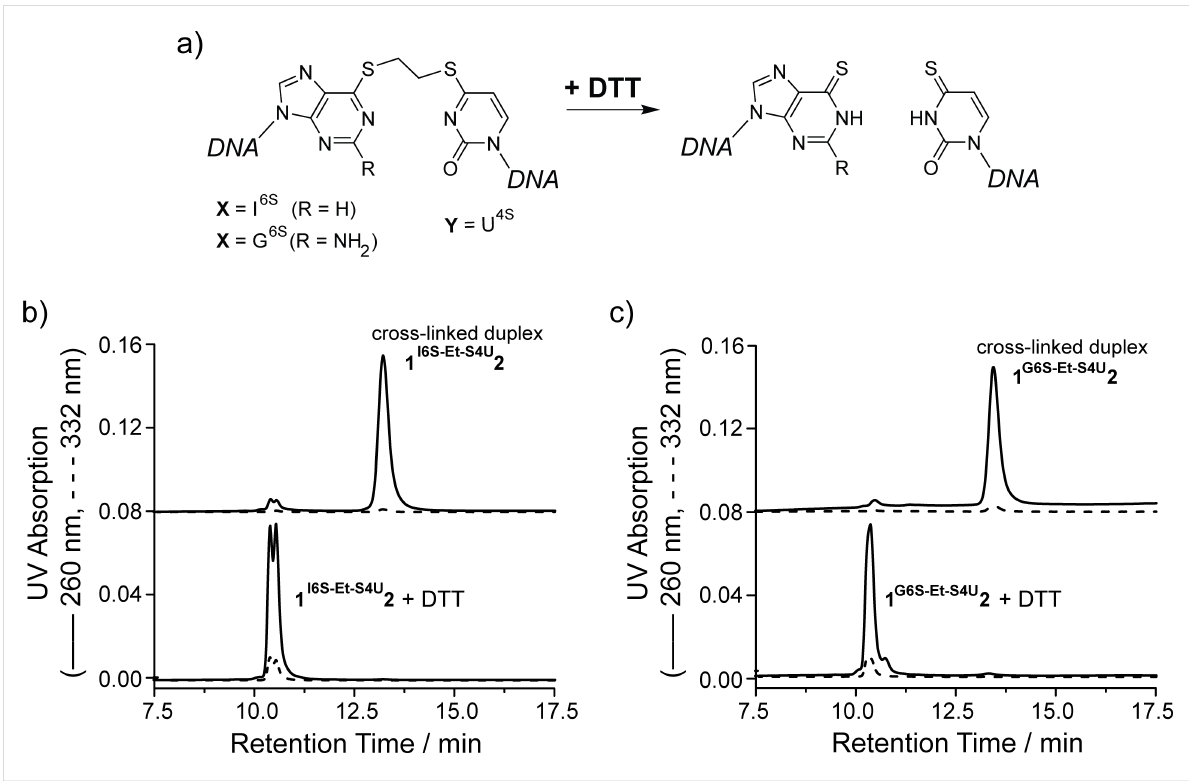
Figure 4: Opening and traceless linker removal of the cross-linked duplexes 1 I6S-Et-S4U 2 and 1 G6S-Et-S4U 2 by adding DTT (a). Denaturing anion exchange HPLC chromatograms (b, c) demonstrate that the reaction products dissociate and elute at the same retention times as their parent single strands. Furthermore, the UV absorption at 332 nm is fully recovered, indicating that the thio-keto function in the nucleobases has been